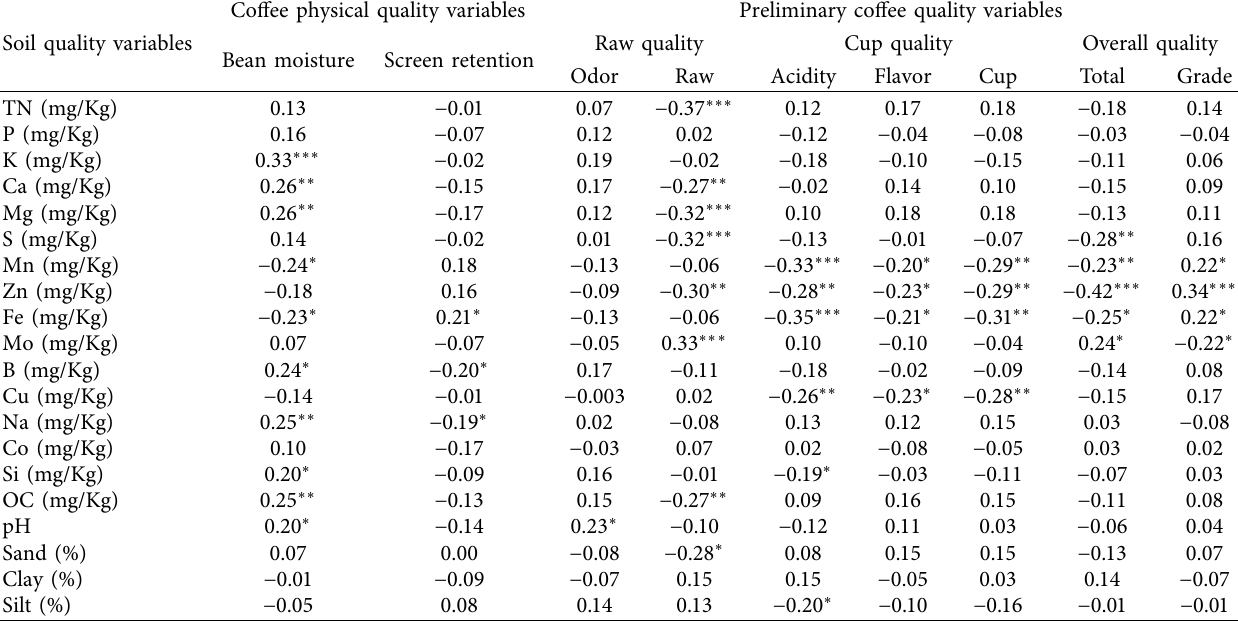
Table 3: Pearson’s correlation coefficients ( r ) of preliminary coffee quality and soil physical and chemical